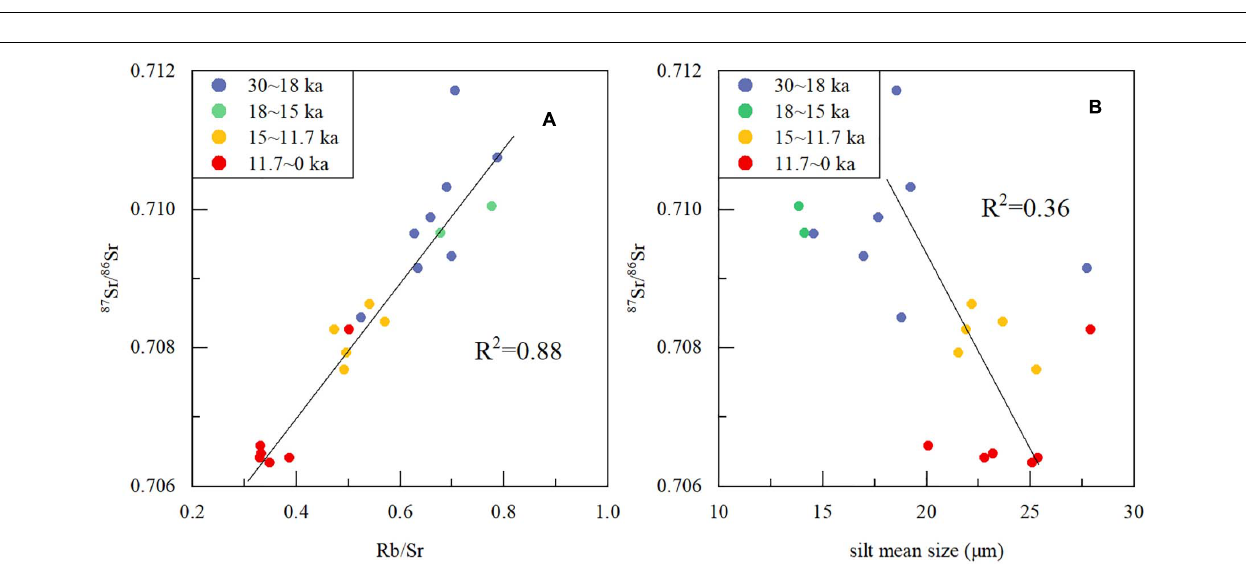
FIGURE 6 | Plots of correlations among (cid:54) REE, silt mean size (A) , and MnO concentration (B) in core LV53-18-2.